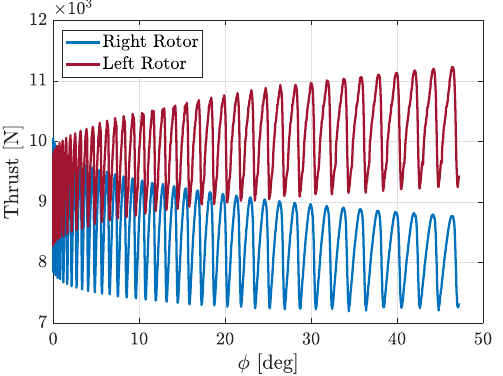
Figure 16. Rotor thrust with respect to bank angle during the roll maneuver.